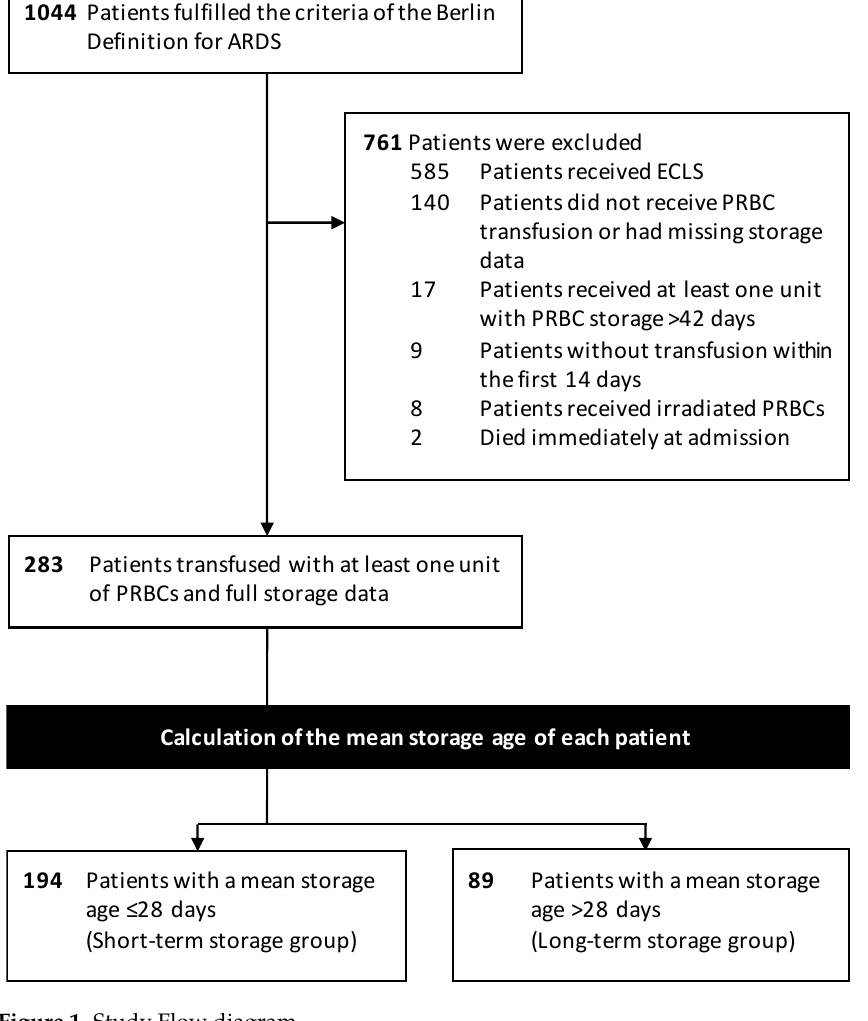
Figure 1. Study Flow diagram.